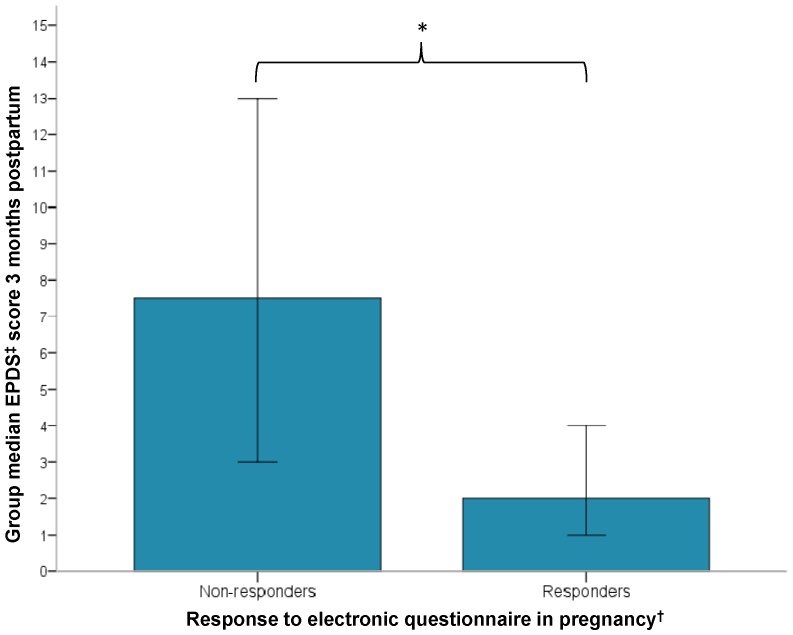
Participant’s response to the electronic questionnaire in pregnancy.Bar chart presenting the median EPDS score measured 3 months postpartum of non-responders (n = 8) and responders (n = 36) to an electronic questionnaire (seafood intake, demography, socioeconomically status, psychological status) in pregnancy. * Significantly difference at the 0.001 level. † 28th week gestation. ‡ Edinburgh postnatal depression scale.